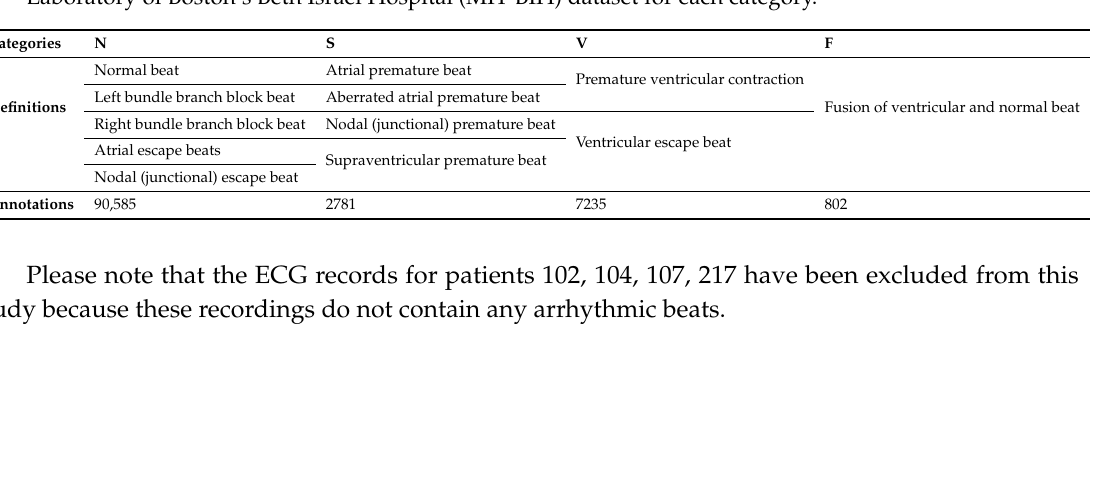
Table 1. Beat classification categories and total number of annotations included in the Arrhythmia Laboratory of Boston’s Beth Israel Hospital (MIT-BIH) dataset for each